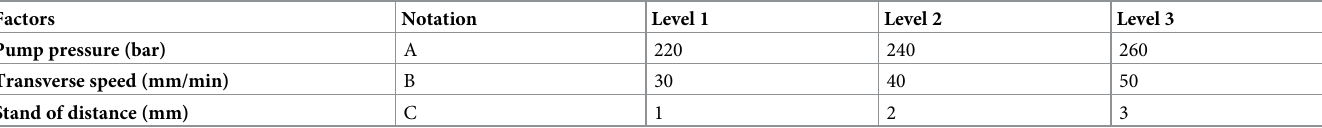
Table 1. Process parameter for machinability